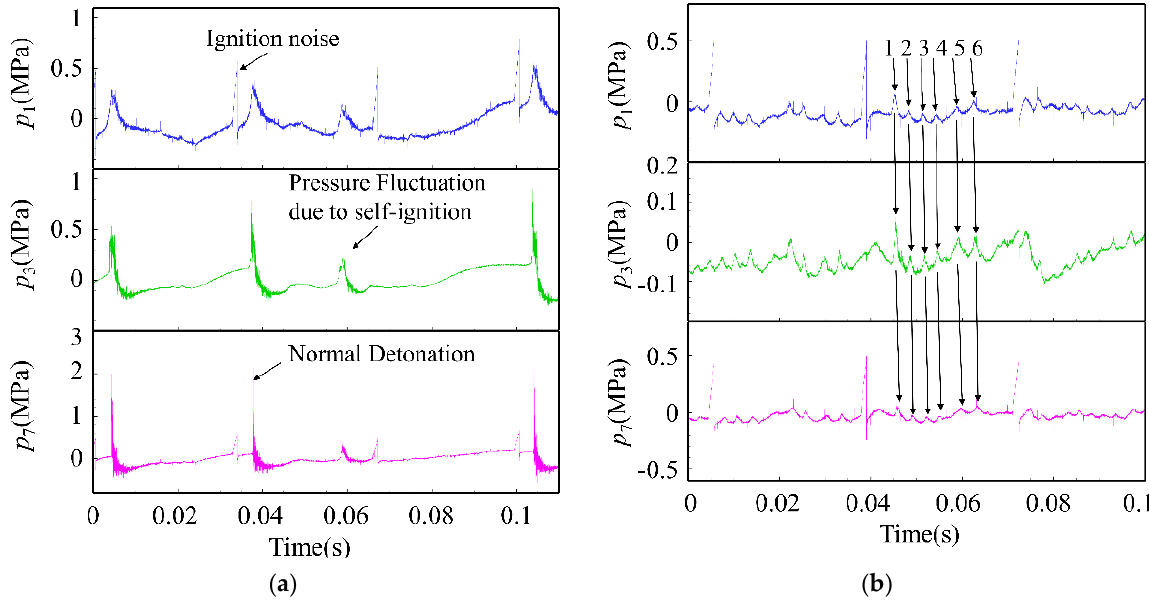
Figure 9. Self-ignition phenomenon with the frequency of 30 Hz under T t = 523 K. ( a ) Self-ignition phenomenon 1. ( b ) Self-ignition phenomenon 2.